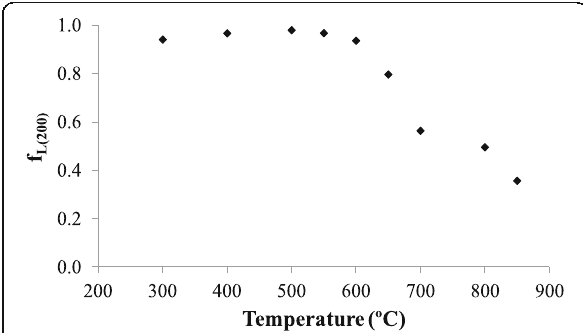
Fig. 2 f L (200) for STO films obtained between 200 and 850 °C at laser frequency and chamber pressure of 10 Hz and 4 × 10 − 4 mbar,